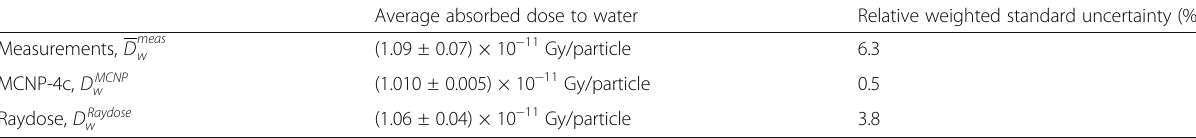
Table 4 Absorbed dose to water measured and calculated by MCNP4c and Raydose MC codes. D meas and D Raydose are in the ratio 1.03, well within the stated uncertainties. D meas while D meas w w using LiF:Mg,Cu,P TLDs. D MCNP w dose per emitted beta particle calculated running Raydose on 90 Y – PET images Average absorbed dose to water Relative weighted standard uncertainty